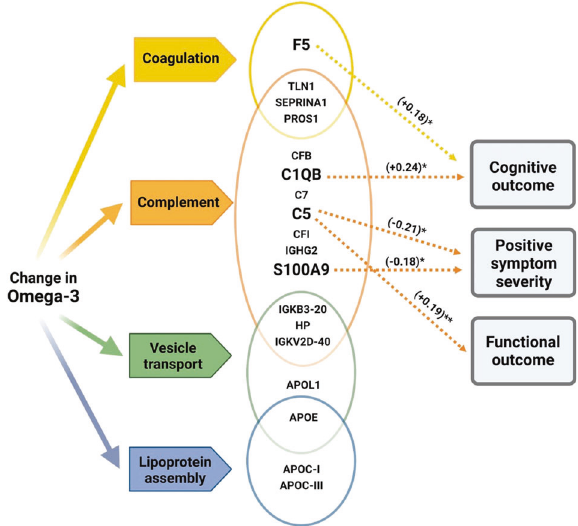
Fig. 2 Schematic representation of key results depicting the relationship of total omega-3 PUFAs, key plasma proteins/pathways, and clinical outcome in a clinically high-risk